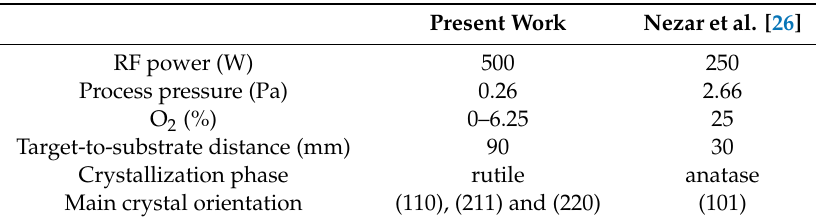
Table 4. Comparison between TiO 2 deposited by RF magnetron sputtering at RT and without any intentional substrate